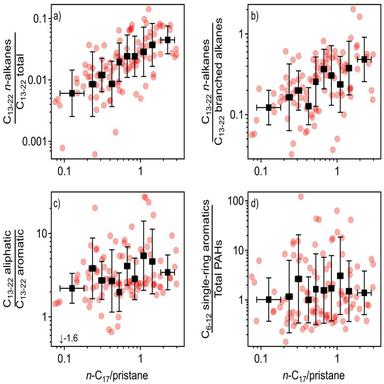
Ratios of various compound classes to the measured n-C17/pristane ratio for all samples with TPH concentrations greater than 10,000 ug/m3. Ratios shown are (a) fraction of total C13–C22 hydrocarbons that are n-alkanes, (b) straight-chain to branched C13–C22 saturated alkanes, (c) aliphatic vs. aromatic content of C13- C22 hydrocarbons, and (d) volatile single-ring aromatics (e.g., BTEX) vs. total PAHs. All data shown as circles, binned into deciles with medians and interquartile ranges shown as squares with